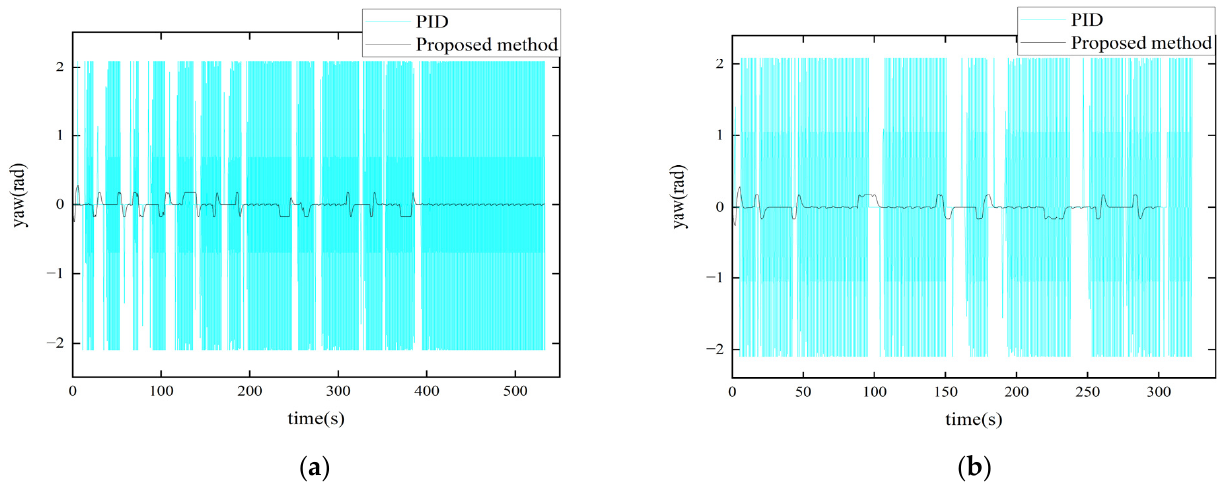
Figure 6. The yaw velocity of paths 1 and 2: ( a ) the yaw velocity of path 1; ( b ) the yaw velocity of path 2.